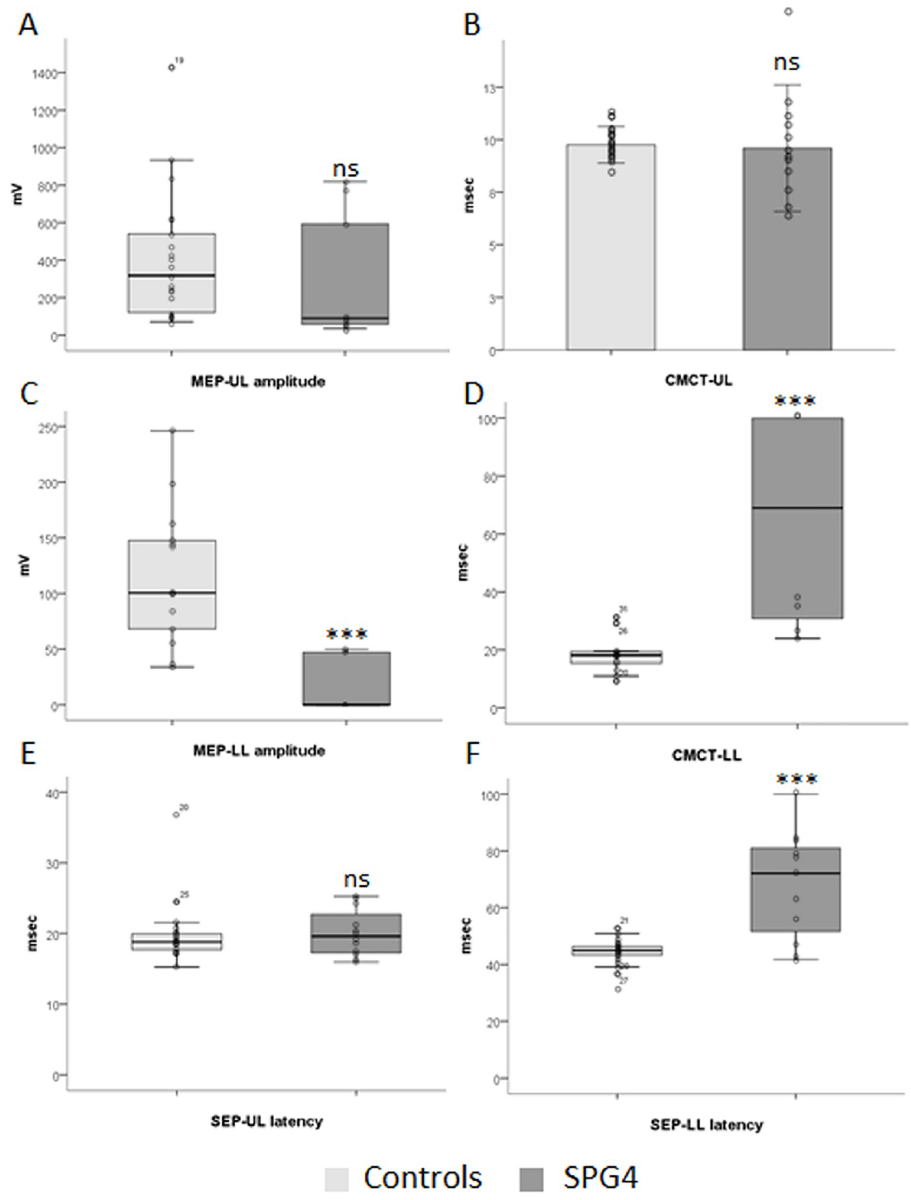
Fig 2. Evoked potentials abnormalities in SPG4. CMCT: Central Motor Conduction Time; HSP: Hereditary spastic paraplegia; LL: lower limbs; MEP: motor evoked potential; msec : milliseconds; mV : millivolt; SSEP : Somatosensory Evoked Potential; UL : upper limbs; μ V : microvolt. ��� p <